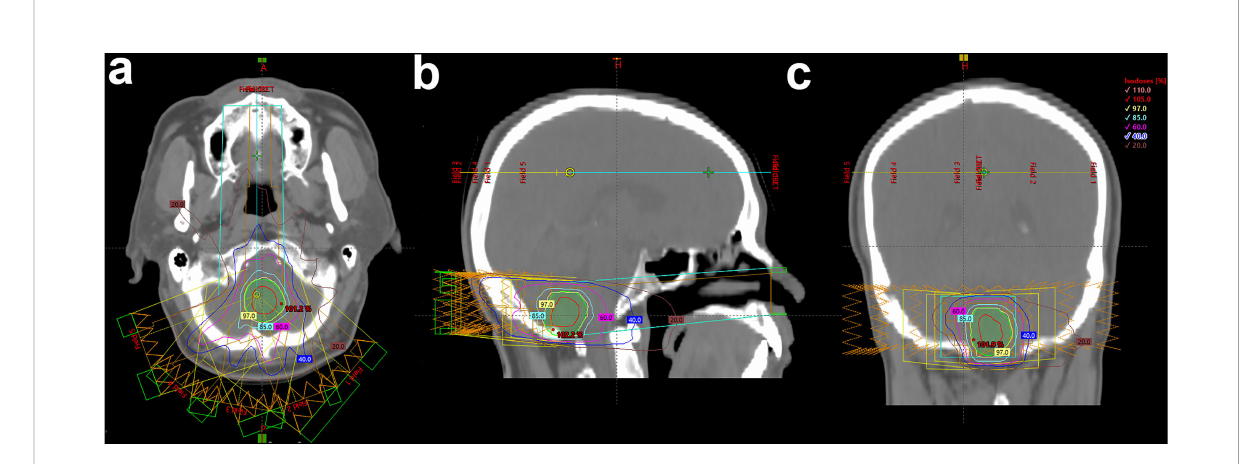
FIGURE 2 Example of the treatment planning of EBRT. (A) Traverse, (B) sagittal, and (C) coronal views of the treatment planning.